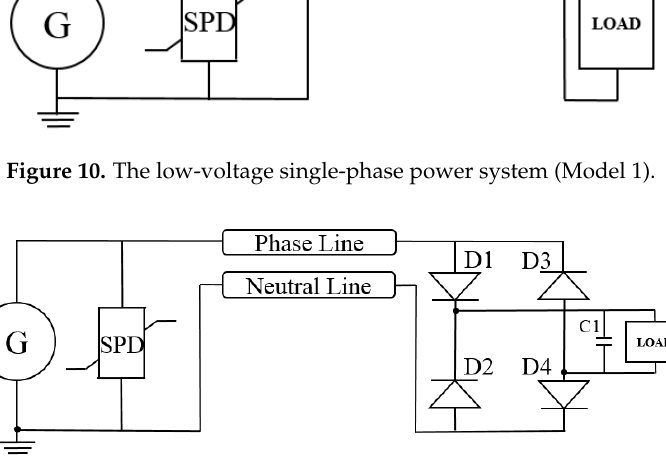
Figure 12. The open-circuit voltage waveform of 6 kV.